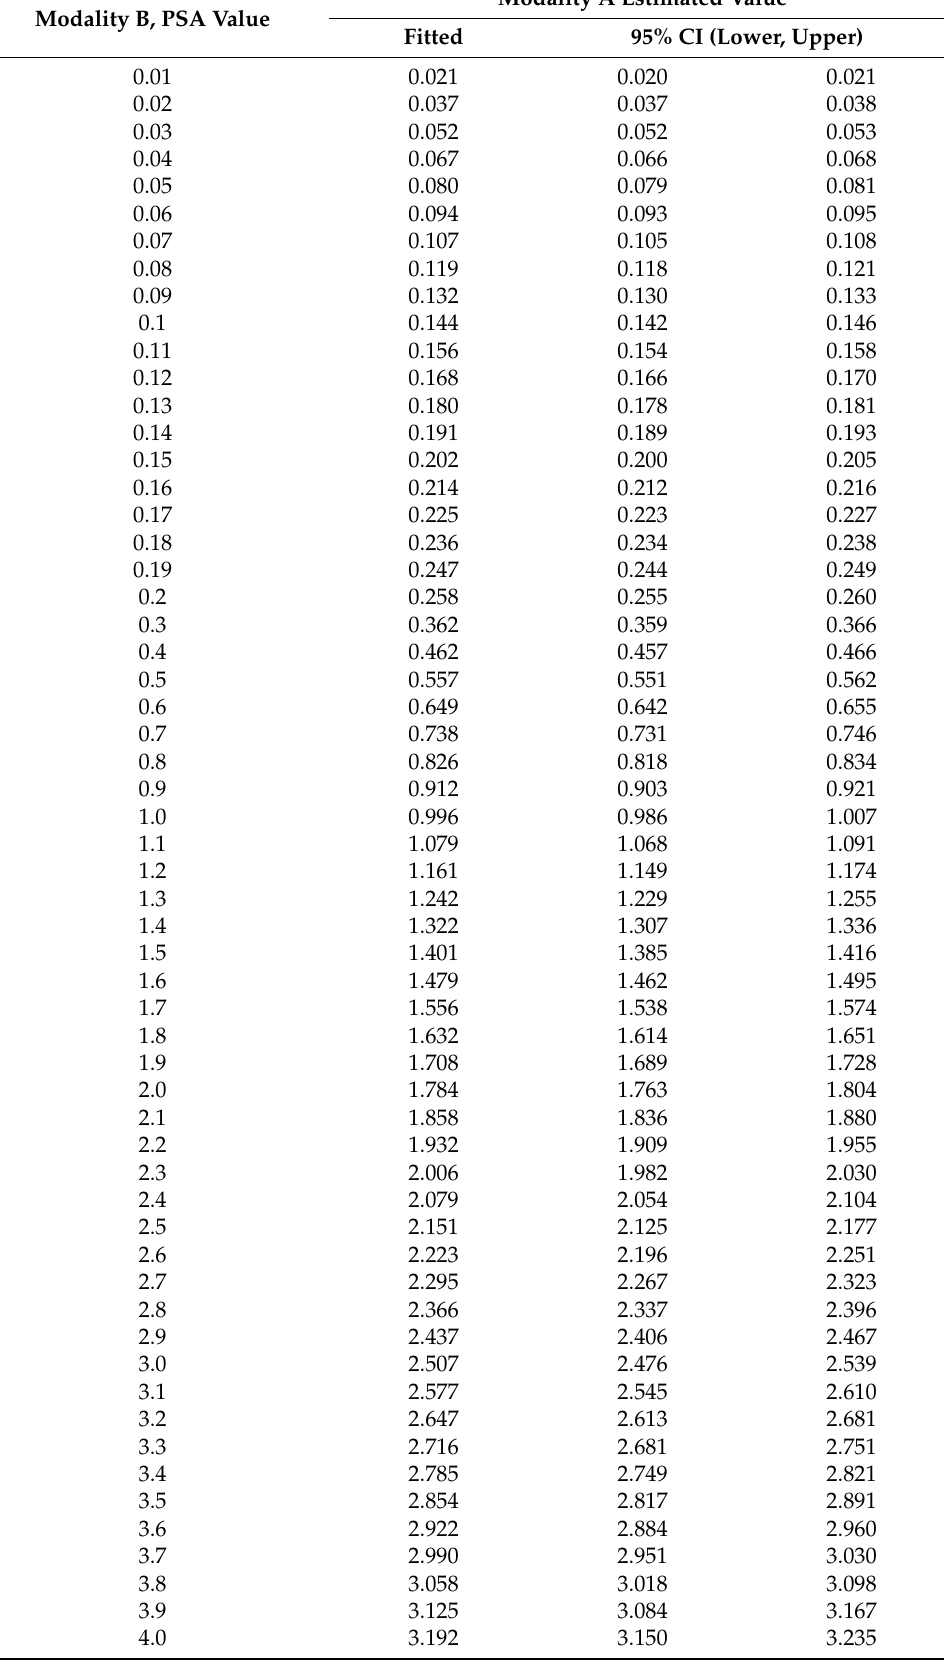
Table 3. Estimated PSA value by different assay